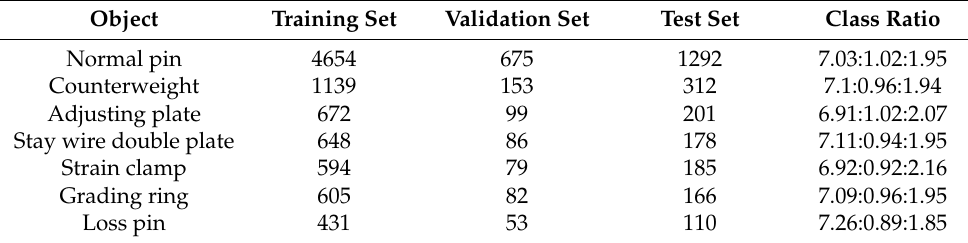
Table 3. The class ratio of each